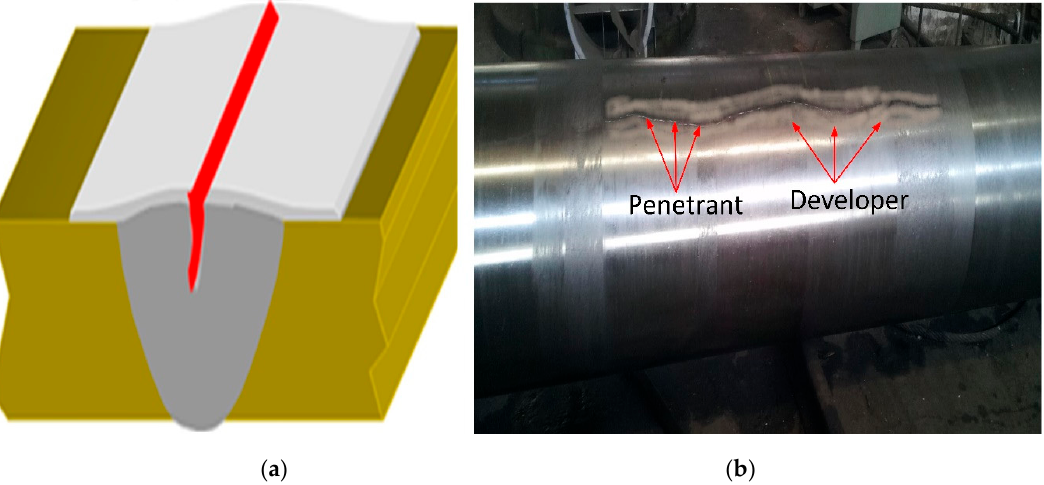
Figure 4. ( a ) Schematic diagram depicting the application of cleaner, penetrant, and developer; ( b ) Sugar mill roller shaft after penetrant testing (PT) . mill roller shaft after penetrant testing (PT)